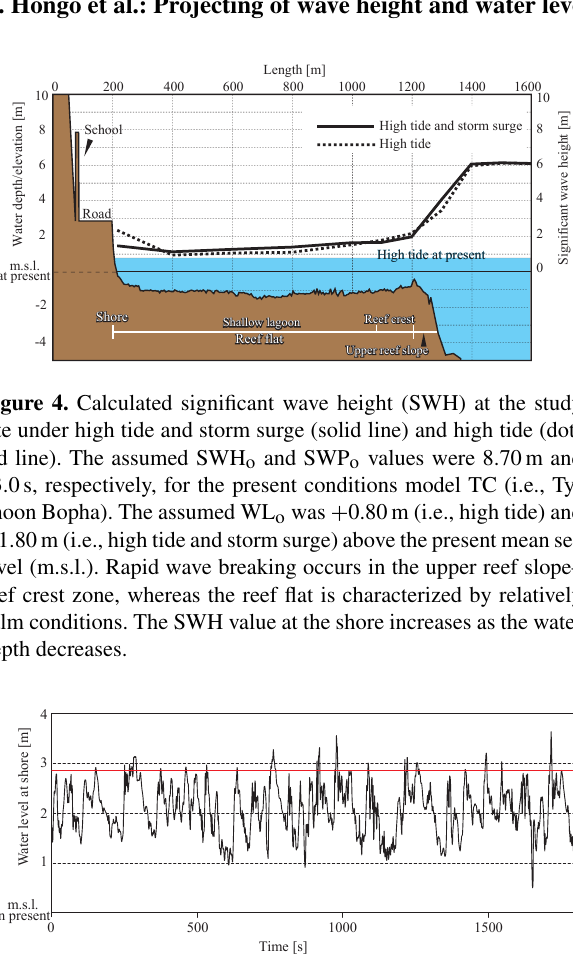
Figure 5. Calculated water level on the shore at the study site under the present-day TC (i.e., Typhoon Bopha). The assumed SWH o and SWP o values were 8.70m and 13.0s, respectively. The assumed WL o was + 1.80ma.m.s.l. (above mean sea level) (i.e., high tide and storm surge). The horizontal solid line in red shows the eleva- tion of the road ( + 2.86m above present m.s.l.) at the study site. The road was frequently flooded.